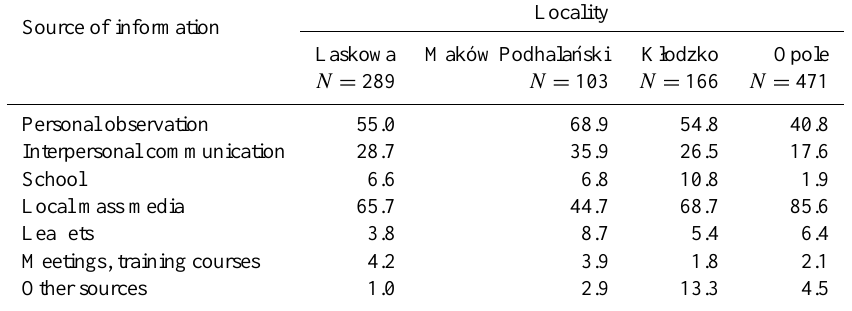
Table 3. Share of the respondents (%) declaring having obtained information about natural hazards from particular sources of information. Source of